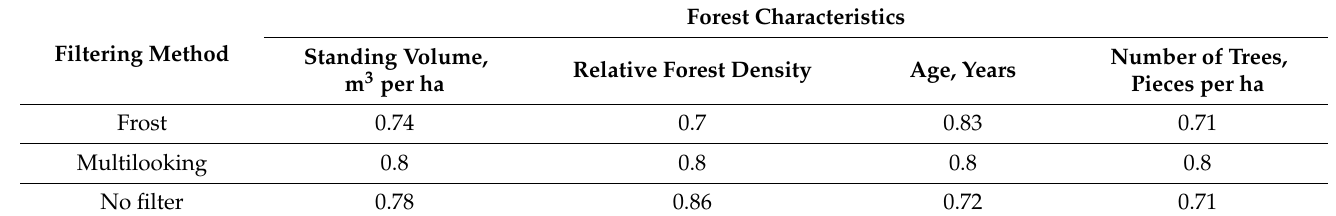
Figure 1. Deciphering forest density according to radar survey data .